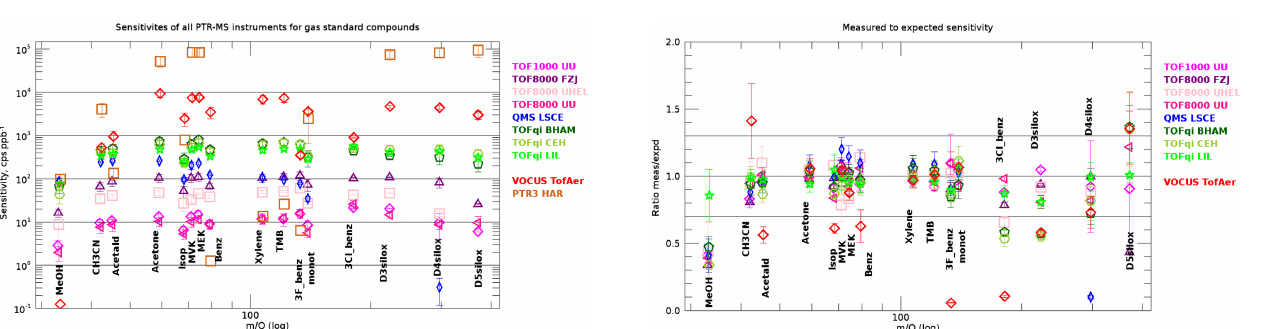
Figure 5. The ratio between measured and expected sensitivities as retrieved from dry injections that were not used for transmission retrievals. The data for most compounds and most instruments are well within ± 30%. The error bars represent the standard deviation of all gas standard injections with dry N 2 or air as carrier gas, except those that were used to calculate the transmission . Compounds as in Fig.